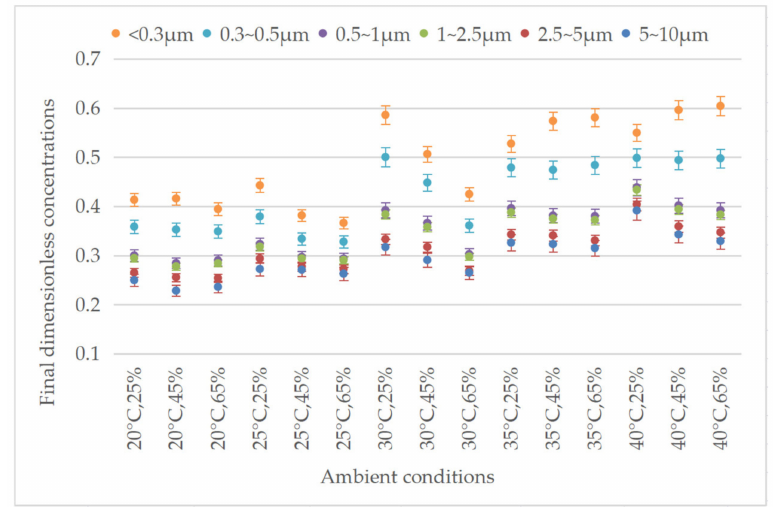
Figure 4. Final dimensionless concentrations of different particle sizes under different ambient conditions.